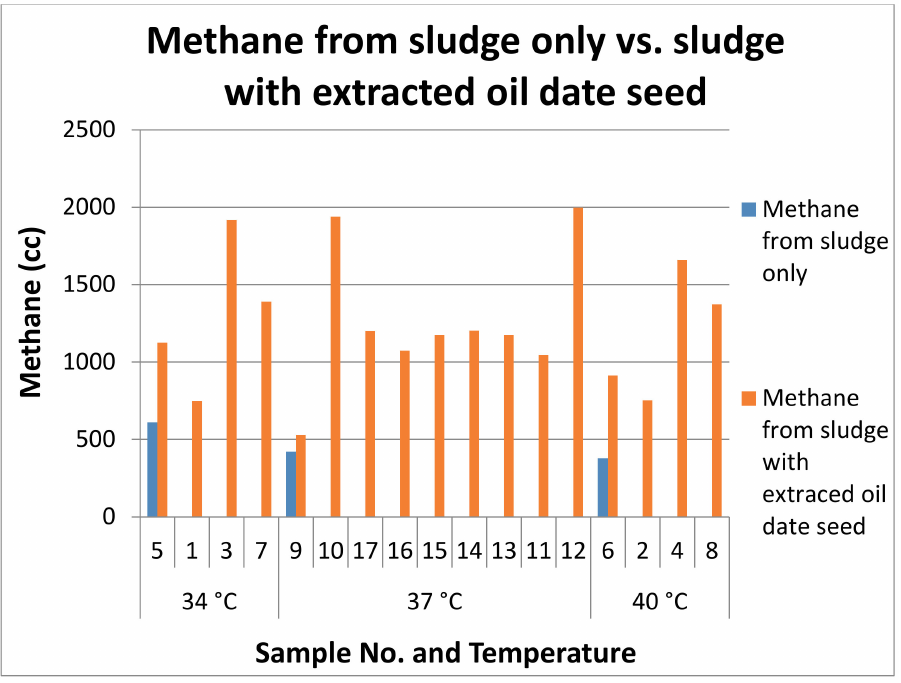
Figure 21. The effect of adding extracted oil date seed on methane